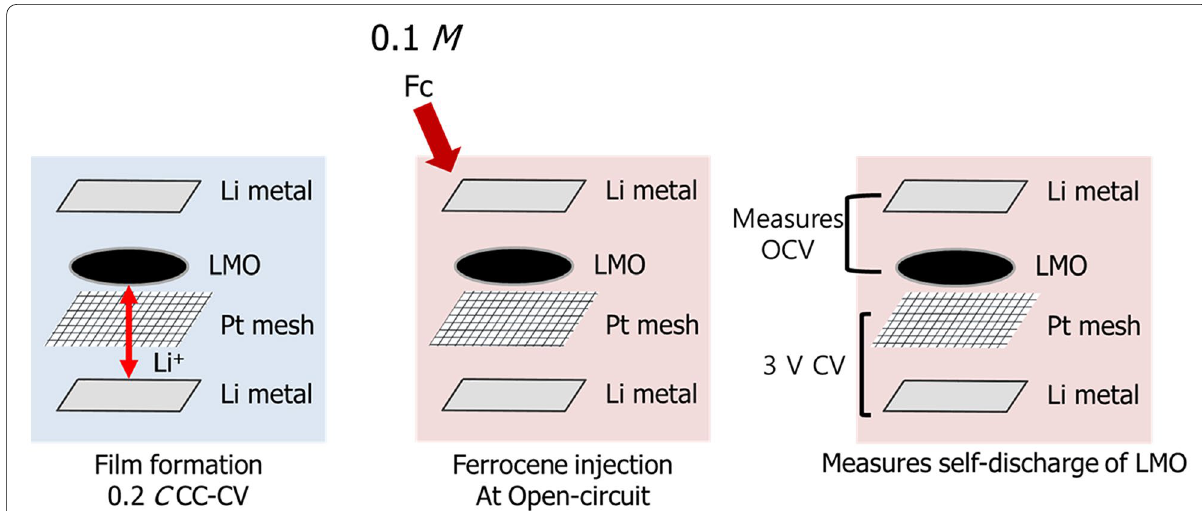
Fig. 3 Experimental Scheme for measuring permeability of surface film deposited on positive electrode surface by redox